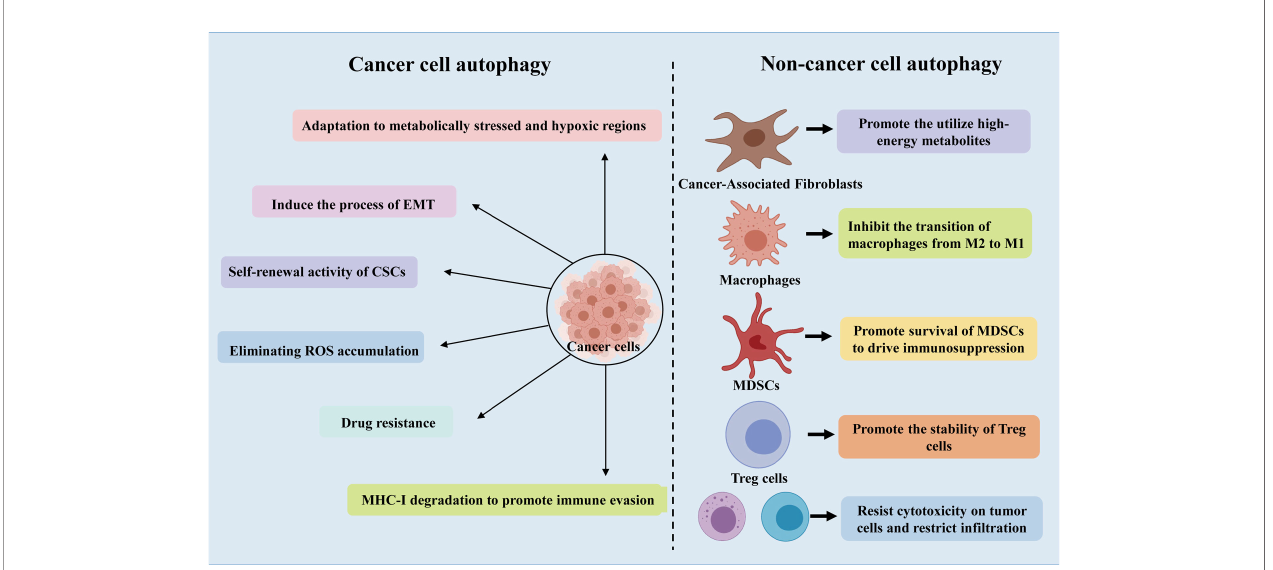
FIGURE 2 | A schematic representation of the role of autophagy in cancer cells and non-cancer